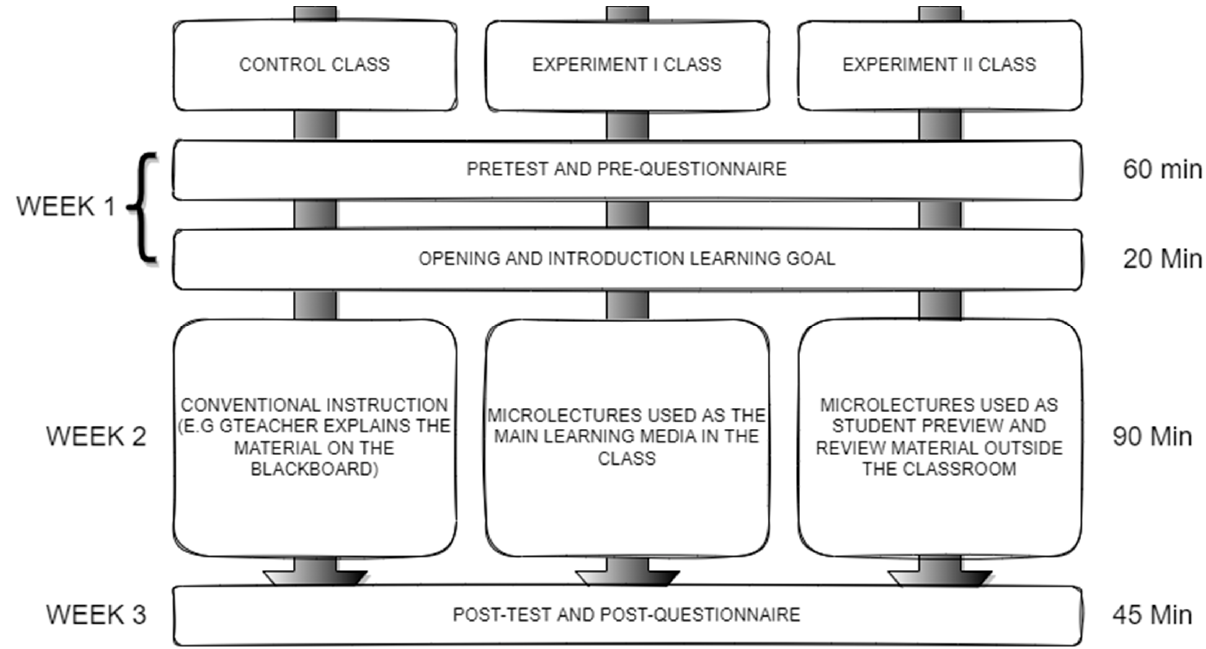
Figure 3. Research procedures.